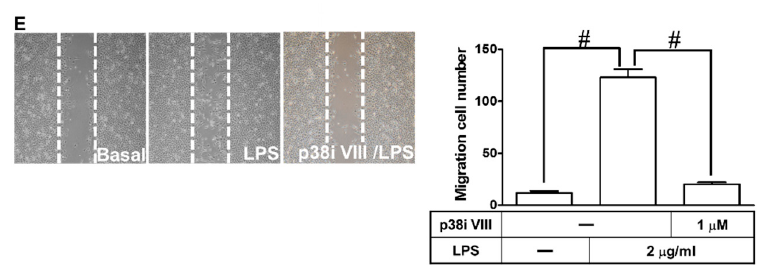
Figure 7. p38 mitogen-activated protein kinase (MAPK) was involved in LPS-induced MMP-9 expression and cell migration. ( A ) RBA-1 cells were pretreated with p38 MAP kinase inhibitor VIII (0.01, 0.1, and 1 μ M) for 1 h, and then incubated with LPS (2 μ g/mL) for 24 h. The levels of MMP-9 were determined by gelatin zymography. The GAPDH level of cell lysates was assayed by western blot. ( B ) Cells were pretreated with p38 MAP kinase inhibitor VIII (1 μ M) for 1 h, and then incubated with LPS (2 μ g/mL) for 4 h for mRNA expression or 6 h for promoter activity. The mRNA expression and promoter activity of MMP-9 were determined by real-time PCR and promoter assay, respectively. ( C ) Cells were transfected with scrambled (Scrb) or p38 siRNA, and then incubated with LPS (2 μ g/mL) for 24 h. The medium and cell lysates were collected to respectively determine the levels of MMP-9 by gelatin zymography, and the levels of GAPDH and p38 MAPK by western blotting. ( D ) Cells were pretreated with or without p38 MAP kinase inhibitor VIII (3 μ M), AG1296 (10 μ M), PF431396 (10 μ M), Akt inhibitor VIII (3 μ M), LY294002 (10 μ M), or c-Src inhibitor II (3 μ M) for 1 h, or separately transfected with TLR4 siRNA, and then challenged with LPS (2 μ g/mL) for the indicated time intervals (0, 10, 30, and 45 min). The phosphorylation of p38 MAPK was determined by western blotting. ( E ) Cells were pretreated with p38 MAP kinase inhibitor VIII (1 μ M) for 1 h, and then incubated with LPS (2 μ g/mL) for 48 h. The number of cell migrations was determined (magnification = 40×). Data are expressed as mean ± SEM of three independent experiments. # p < 0.01 as compared with the cells exposed to vehicle or LPS, as indicated.